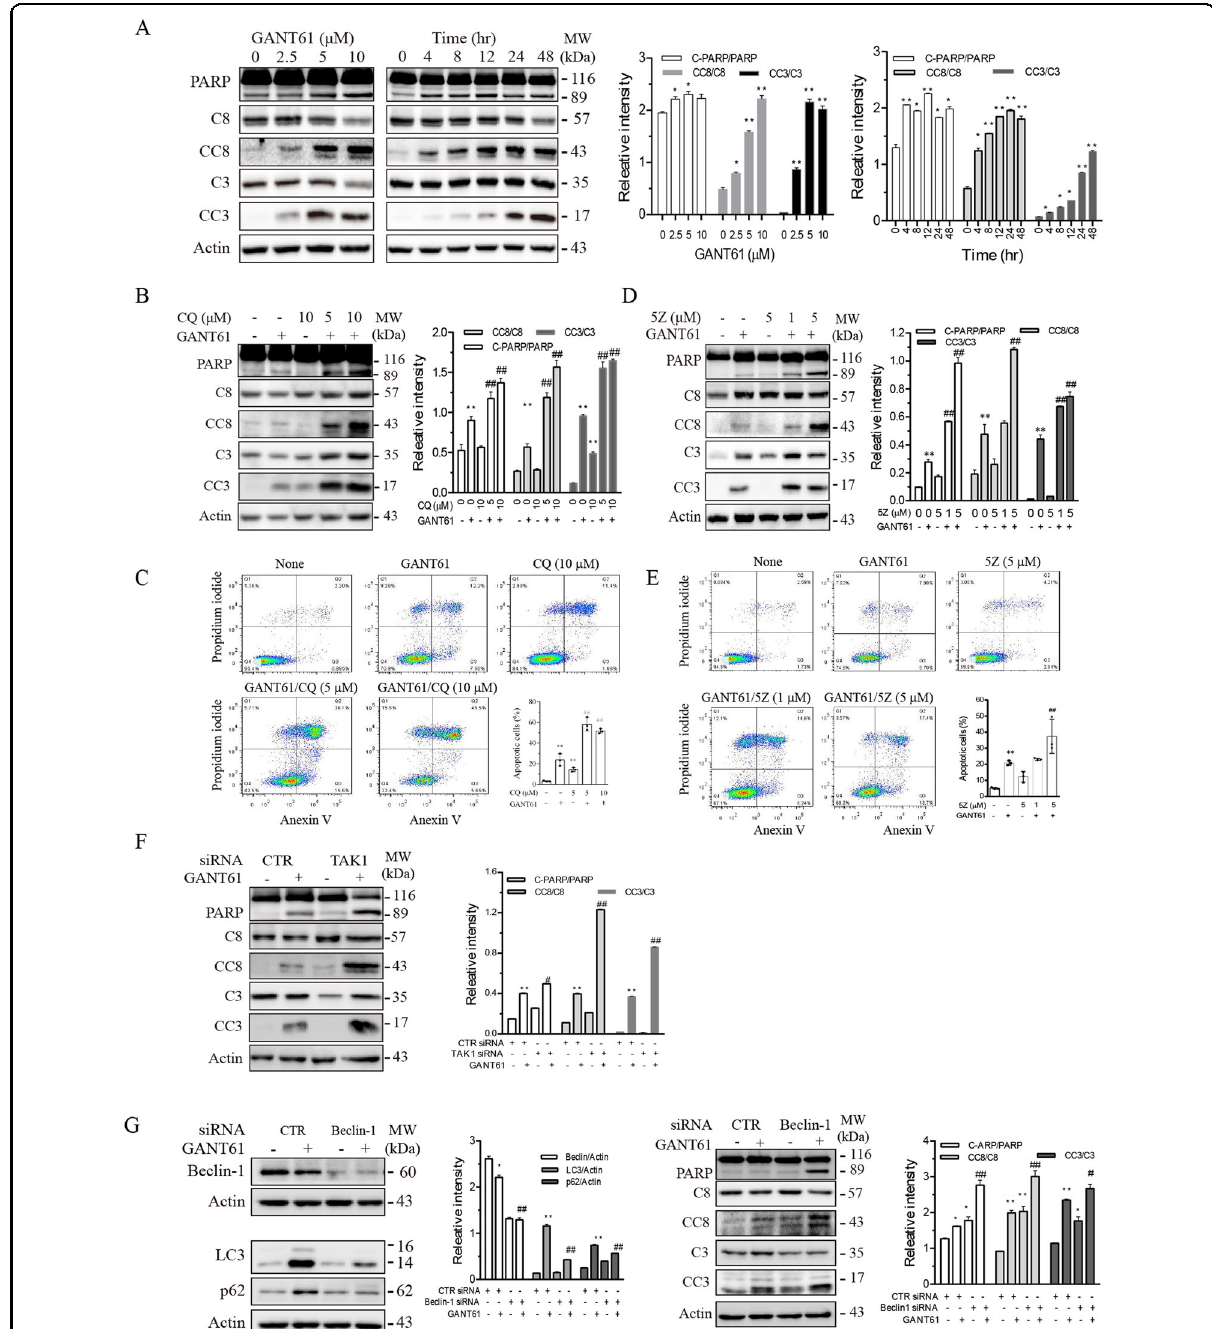
Fig. 5 Inhibition of autophagy enhances GANT61-induced apoptosis. A SW1736 cells were treated with the indicated concentrations of GANT61 for 48 h or with 10 μ M GANT61 for the indicated lengths of time. B , D SW1736 cells were incubated in the absence or presence of GANT61 (10 μ M) minus or plus 5Z (1 or 5 μ M) ( B ) or CQ (5 or 10 μ M) ( D ) for 24 h. Cell lysates were prepared and analyzed for PARP, caspase-8 (C8), cleaved caspase-8 (CC8), caspase-3 (C3), and cleaved caspase-3 (CC3) by western blot. C-PARP cleaved PARP. C , E SW1736 cells were incubated in the absence or presence of GANT61 (10 μ M) minus or plus 5Z (1 or 5 μ M) ( C ) or CQ (5 or 10 μ M) ( E ) for 24 h. Single-cell suspensions were stained for propidium iodide (PI) and annexin V followed by fl ow cytometry. Data in bar graphs are the mean ± SD of three independent experiments. F , G SW1736 cells were transfected with scrambled or TAK1 siRNA ( F ) or Beclin-1 siRNA (2.5 nmole each) ( G ). After incubation for 24 h, the cells were left untreated or treated with GANT61 for 24 h. Cell lysates were analyzed for p62, LC3, Beclin-1, TAK1, PARP, C8, CC8, C3, CC3, and β -Actin by western blot. The expression levels were analyzed by quanti fi cation of the density of the protein bands with NIH Image-J software and presented as bar graphs. * p < 0.05; **p < 0.01, compared to the untreated control; # p < 0.05; ## p < 0.01, compared to GANT61 ( A – E